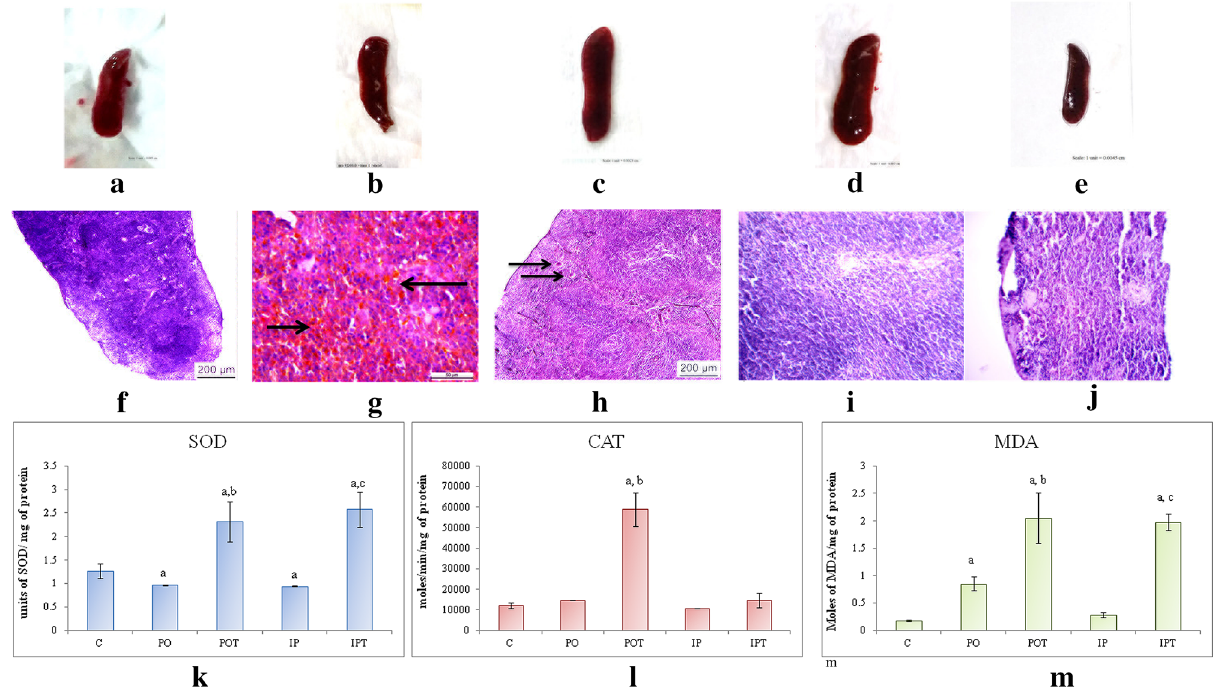
Figure 7. Spleen of ( a ) control, ( b ) PO group, ( c ) IP group, ( d ) POT treatment, ( e ) IPT group. Photomicrographs of TS of spleen ( f ) control (HE, ×100) ( g ) PO-showing apoptotic cells (arrows) (HE, ×100) ( h ) IP-showing haemorrhage (HE, ×400) ( i ) POT-showing no pathological changes (HE, ×100) ( j ) IPT- showing normal architecture of the cells (HE, ×100). ( k ) Comparison of SOD activity in spleen of the control, experimental and treated animals. ( l ) Comparison of CAT activity in spleen of the control, experimental and treated animals. ( m ) Comparison of MDA activity in spleen of the control, experimental and treated animals. The results of biochemical assays and spleen size are shown in mean ± SE (‘a’ symbolizes p < 0.005 control vs experimental groups, ‘b’ symbolizes p < 0.005 experimental vs treatment groups (PO vs POT) and ‘c’ symbolizes p < 0.005 IP vs IPT).